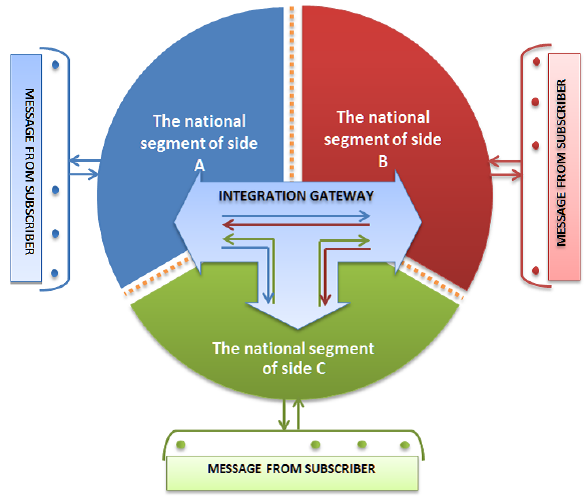
Figure 1: The cross-border information exchange in the integrated